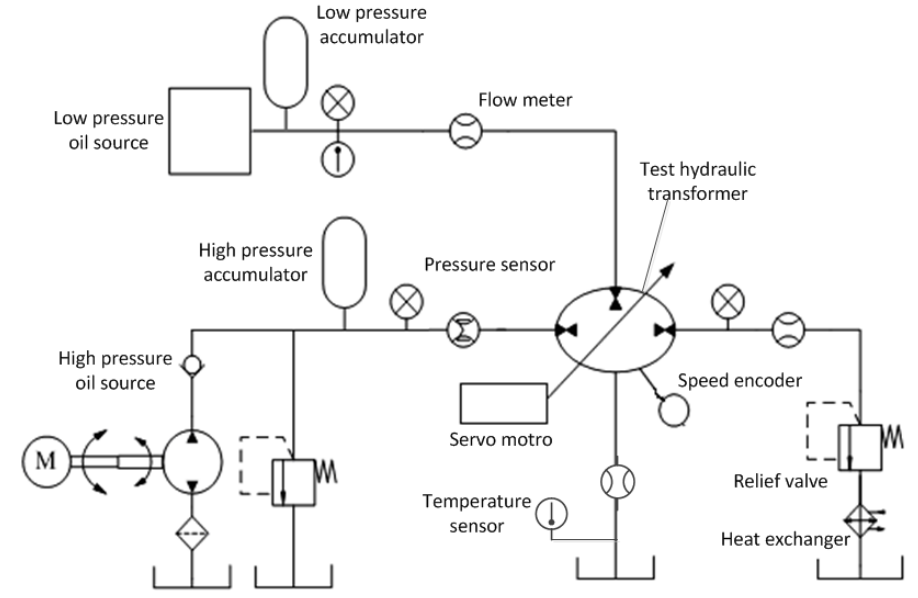
Figure 5. Schematic of the experimental system. Table 1. Details of the sensors and equipment used in the test of the inclined-axis hydraulic transformers.